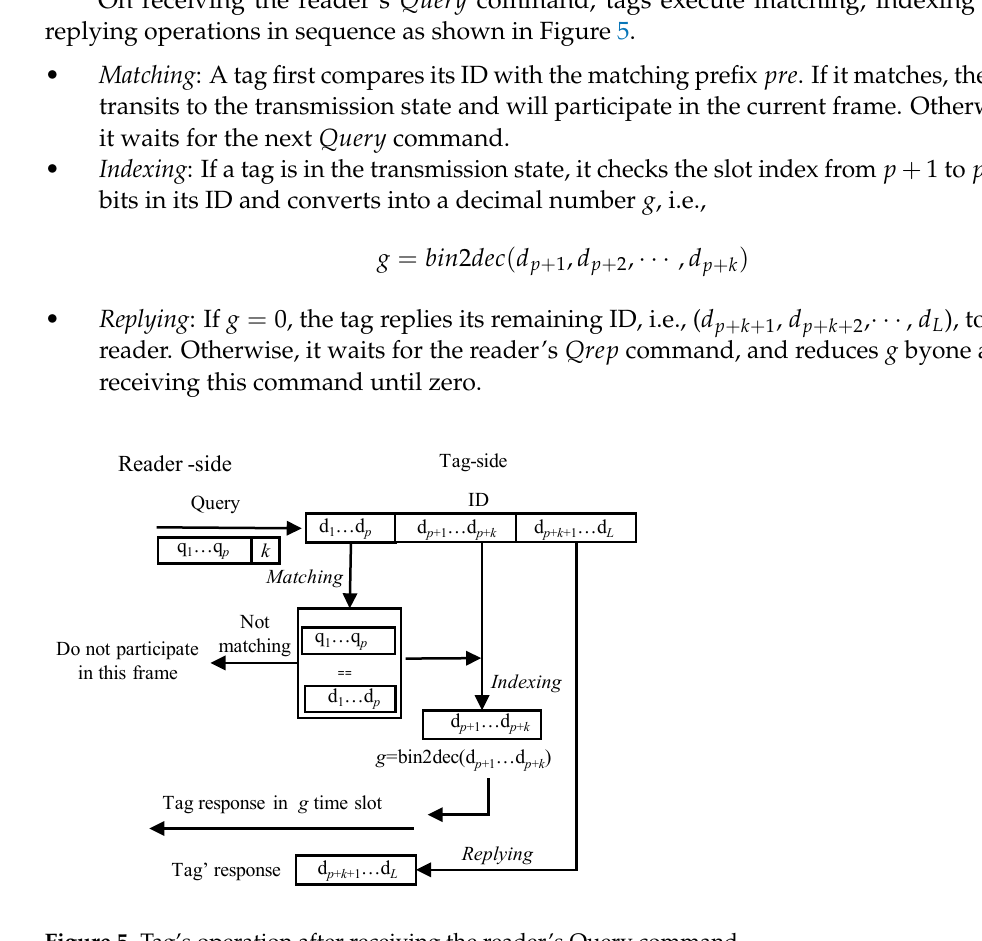
Figure 5. Tag’s operation after receiving the reader’s Query